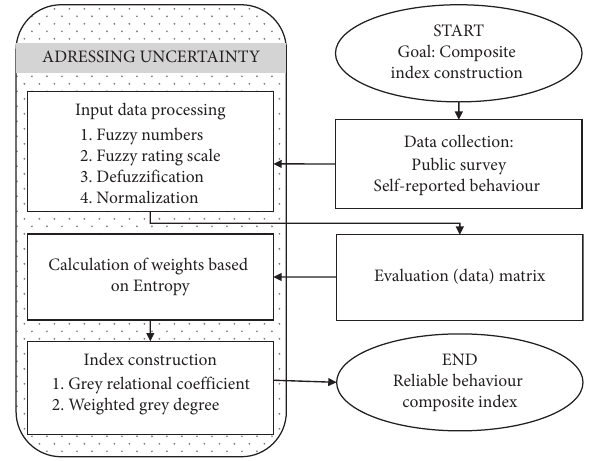
Figure 1: Flow chart of the proposed